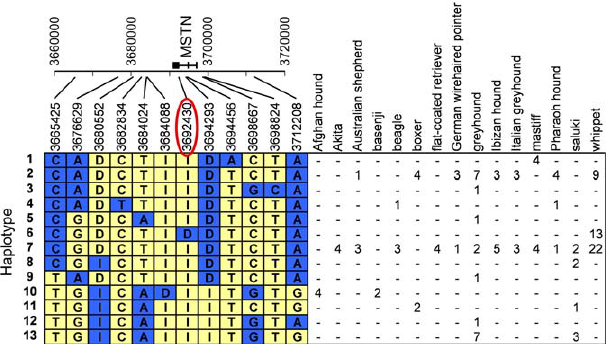
Figure 5. Haplotypes Spanning the MSTN Gene Interval from 15 Dog Breeds SNPs and indels were genotyped from sequence reads aligned by Phrap. Insertions and deletions are indicated by I and D, respectively. Haplotypes are shown on the left side with alleles colored yellow if they match the golden jackal, or blue otherwise. The golden jackal is missing data for markers at positions 3,698,667 and 3,698,824 so the most common allele was assumed to be the ancestral allele and was colored yellow. Marker positions and the MSTN gene are shown to scale along Chromosome 37 in the plot at the top left. The table to the right shows the number of chromosomes inferred to carry the haplotype in any given breed. Haplotypes were inferred by PHASE independently for each breed and the most likely haplotype pair was selected for each individual. The mh mutation (nucleotide position 3,692,430 circled in red) occurs on just one haplotype and is observed only in the whippet breed.